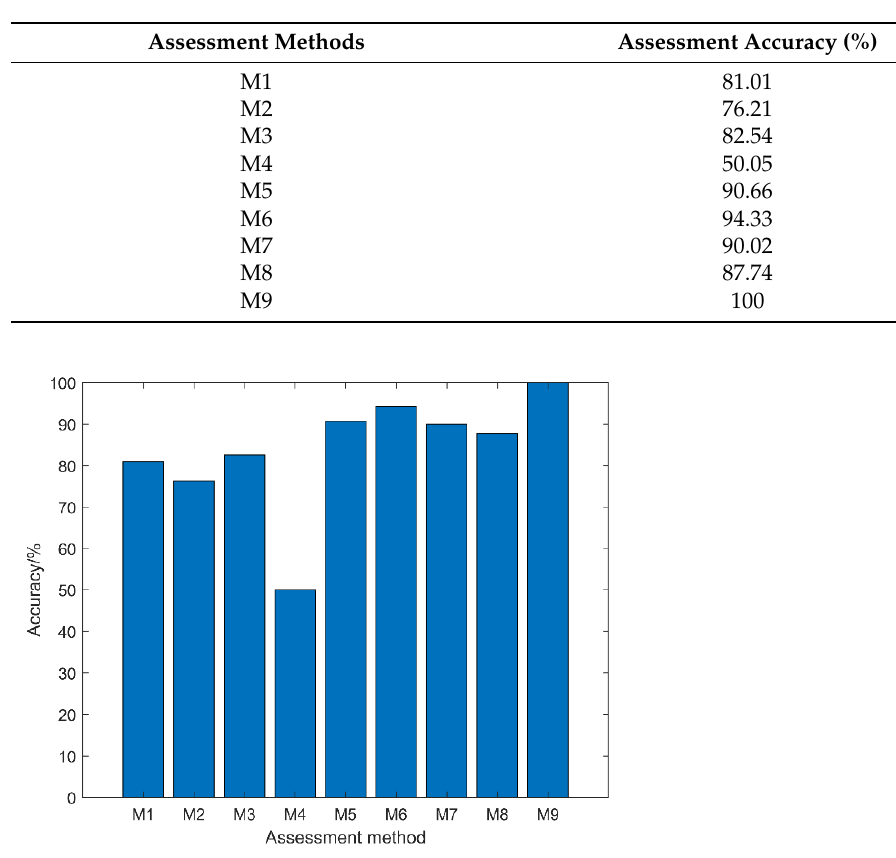
Table 10. Assessment results under different assessment methods.